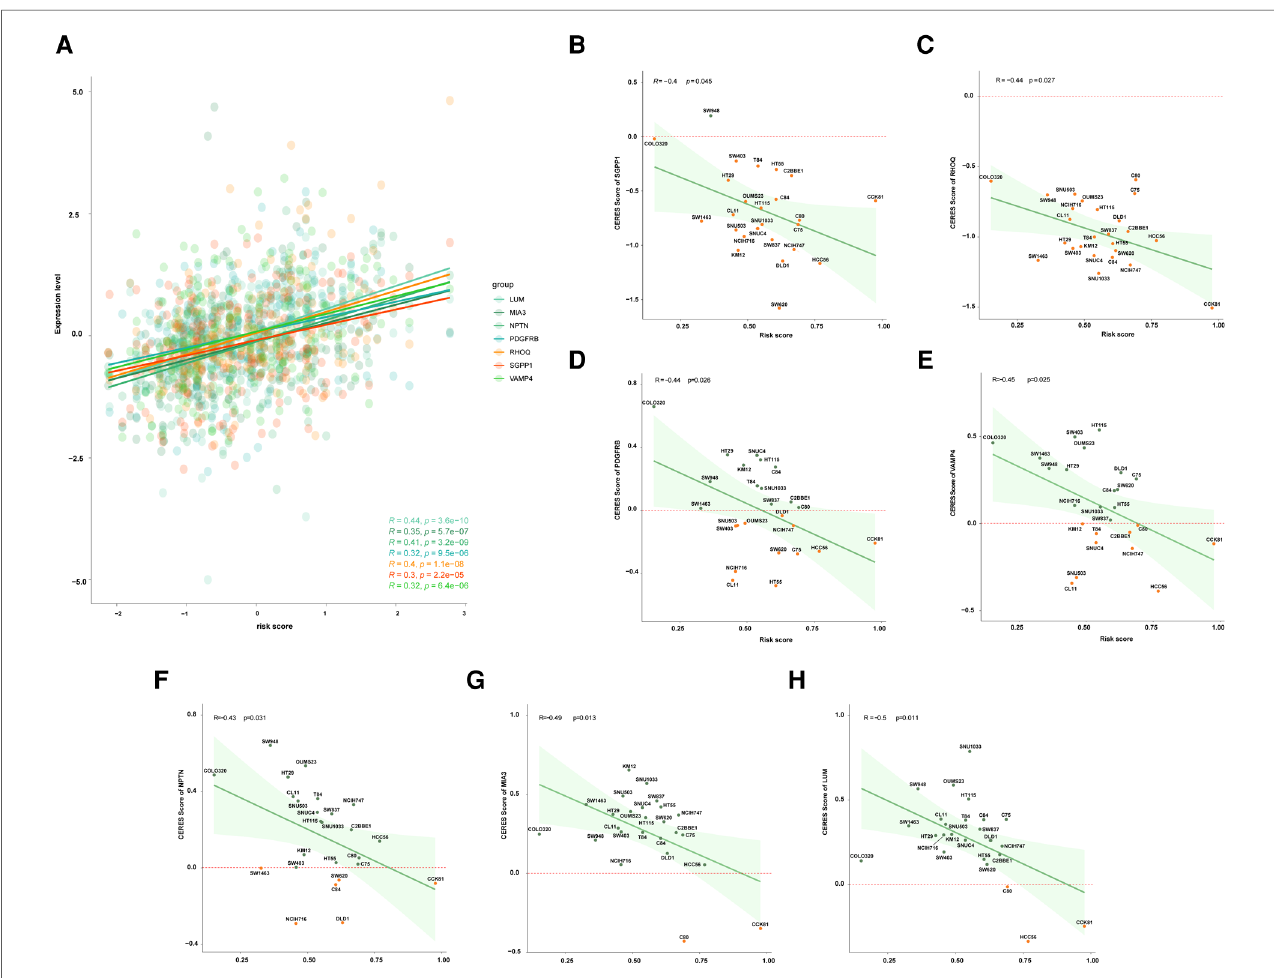
FIGURE 5 Exploration of potential therapeutic target for patients with high risk. ( A ) The correlation between risk score and expression level of LUM, MIA3, NPTN, PDGFRB, RHOQ, SGPP1, and VAMP4. ( B ) The correlation between risk score and the CERES score of SGPP1 in multiple TP53 mutant COAD cell lines. ( C ) The correlation between risk score and the CERES score of RHOQ in multiple TP53 mutant COAD cell lines. ( D ) The correlation between risk score and the CERES score of PDGFRB in multiple TP53 mutant COAD cell lines. ( E ) The correlation between risk score and the CERES score of VAMP4 in multiple TP53 mutant COAD cell lines. ( F ) The correlation between risk score and the CERES score of NPTN in multiple TP53 mutant COAD cell lines. ( G ) The correlation between risk score and the CERES score of MIA3 in multiple TP53 mutant COAD cell lines. ( H ) The correlation between risk score and the CERES score of LUM in multiple TP53 mutant COAD cell